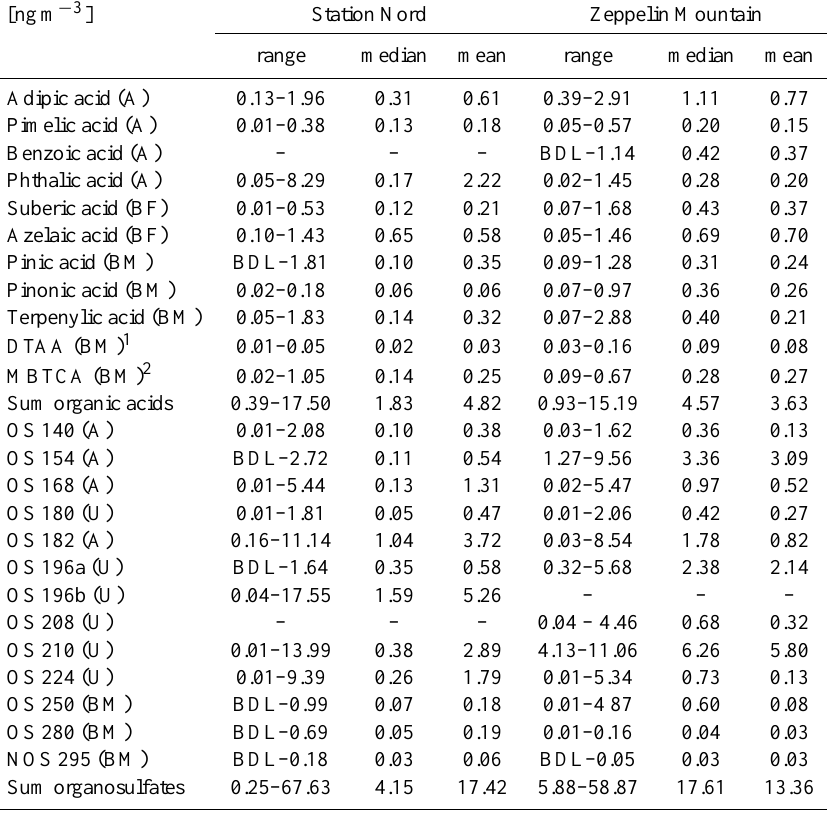
Table 2. Concentration ranges, median concentrations and mean concentrations of the individual and summed organic acids and organosul- fates observed at Station Nord and at Zeppelin Mountain. Anthropogenic compounds are marked with (A), unknown compounds with (U), biogenic compounds from fatty acids with (BF) and biogenic compounds from monoterpenes with (BM). All values are in ngm − 3 . BLD denotes values below detection